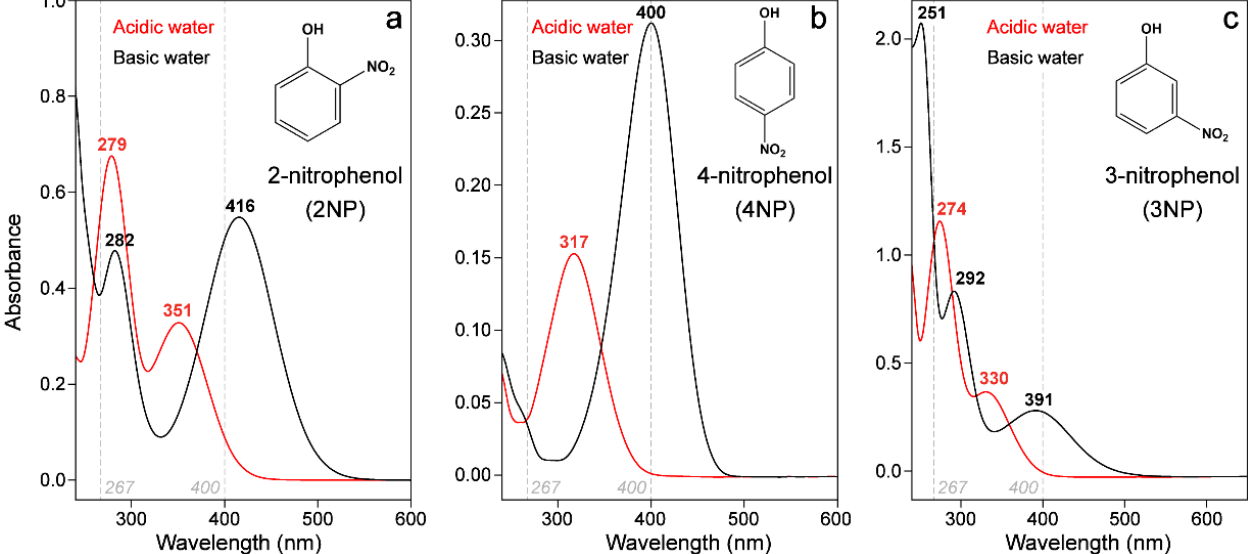
Figure 1. Steady-state absorption measurements of the three nitrophenols (red) and their deprotonated forms (black) in water. The wavelength of each prominent peak is indicated for ( a ) 2NP, ( b ) 4NP, and ( c ) 3NP in acidic (red) and basic (black) aqueous solutions. The pHs of the acidic and basic water solutions were ~4 and 10, respectively; exact values are in the Supplementary Materials (see Figure S1). The concentrations of each nitrophenol sample are identical across acidic and basic conditions to manifest the difference in absorptivity between the protonated and deprotonated molecules in aqueous solution. The two excitation wavelengths at 267 and 400 nm are denoted by vertical dashed gray lines.